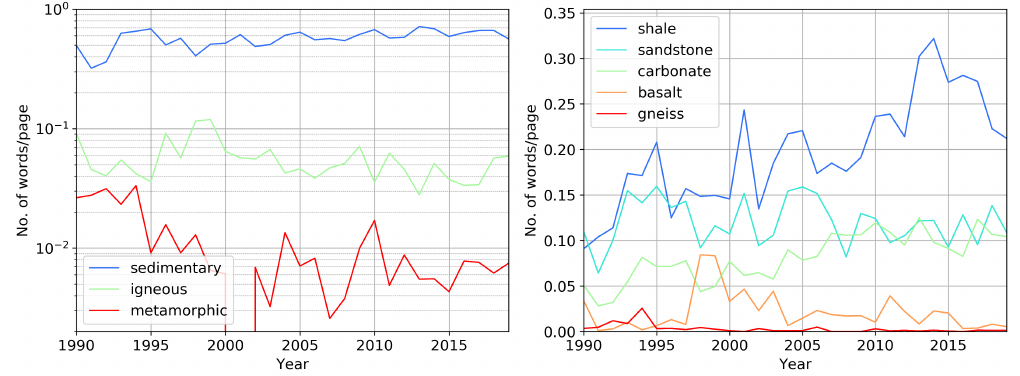
Figure 3. Frequency of use of different rock type names ( left ) and most often used rock names ( right ). Rock types include most common rocks, e.g., sedimentary: shale, sandstone, carbonate; igneous: granite, diorite, basalt, etc.; metamorphic: gneiss, phyllite, slate, etc.